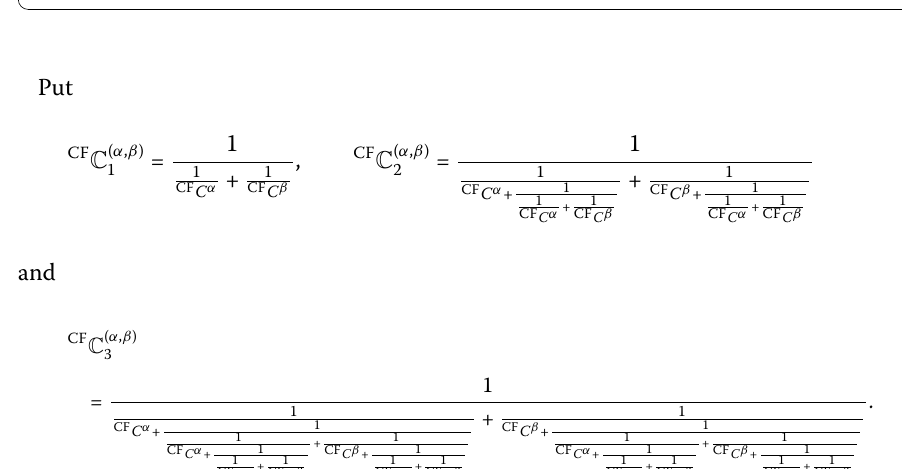
Figure 3 A coefficient-symmetric generation tree composed of the operators CF C α and CF C β